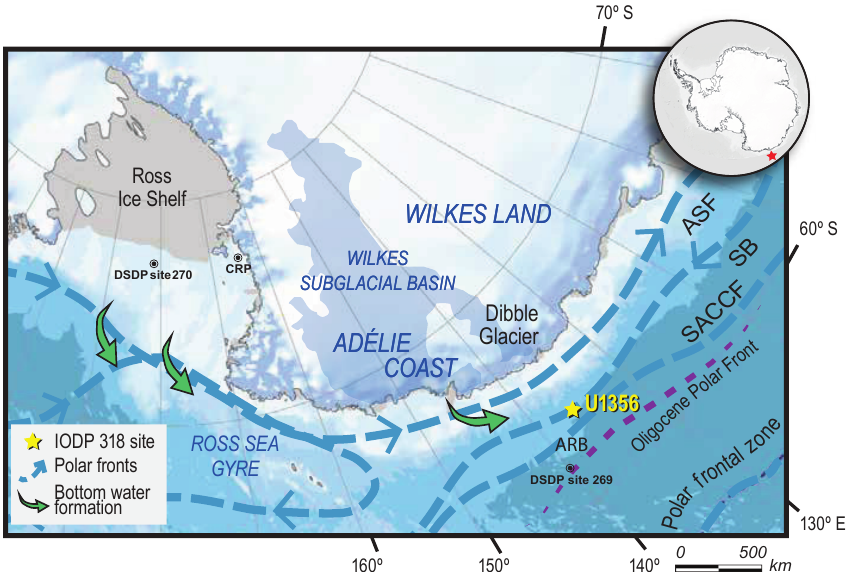
Figure 1. Location of IODP 318 Site U1356 (Escutia et al., 2010) on the Adélie Coast continental rise. Bed topography from IBSCO2 (Arndt et al., 2013). Schematic position of the different water masses at present and locations of Antarctic Bottom Water formation (Orsi, 1995) are indicated. The position of the Oligocene Polar Front (Scher et al., 2015) is also shown. ASF: Antarctic Slope Front; SB: southern boundary; SACCF: Southern Antarctic Counter Current Front; ARB: Adélie Rift